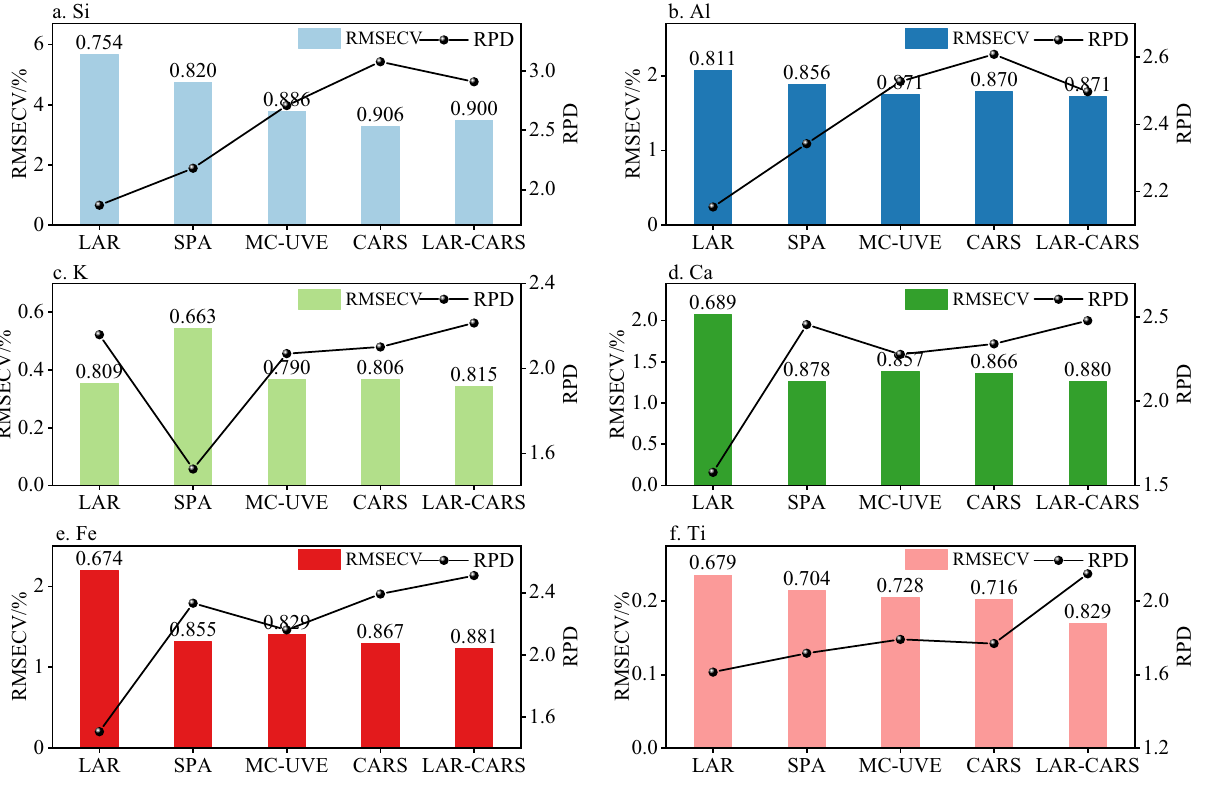
Figure 7. XGBoost modeling results of LOOCV set, ( a ) Si, ( b ) Al, ( c ) K, ( d ) Ca, ( e ) Fe, ( f ) Ti. *The bar chart is labeled R 2 for this